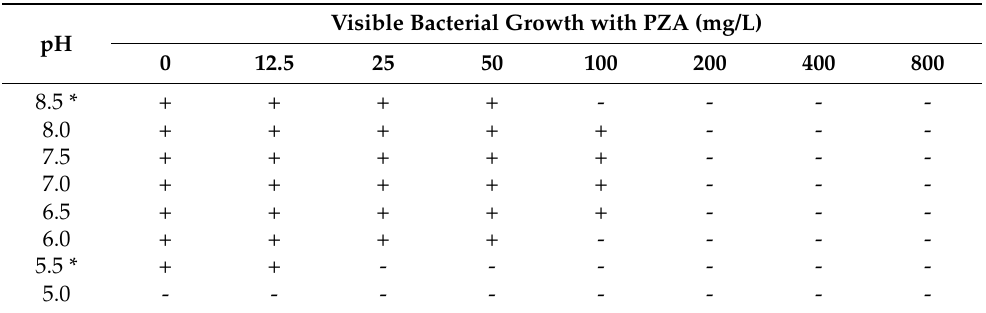
Table 2. Activity of PZA against M. tuberculosis H37Ra according to the acidity of the PZA-S1 medium.